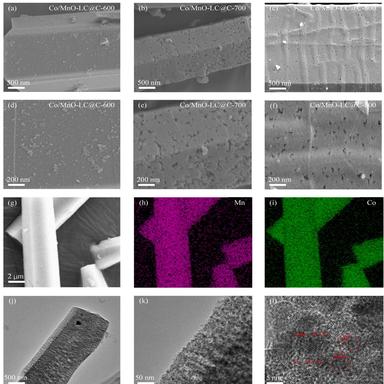
SEM images for (a, d) Co/MnO-LC@C-600, (b, e) Co/MnO-LC@C-700, (c, f) Co/MnO-LC@C-800. (g-i) EDS mappings for Co/MnO-LC@C-700. (j-l) TEM images for Co/MnO-LC@C-700.